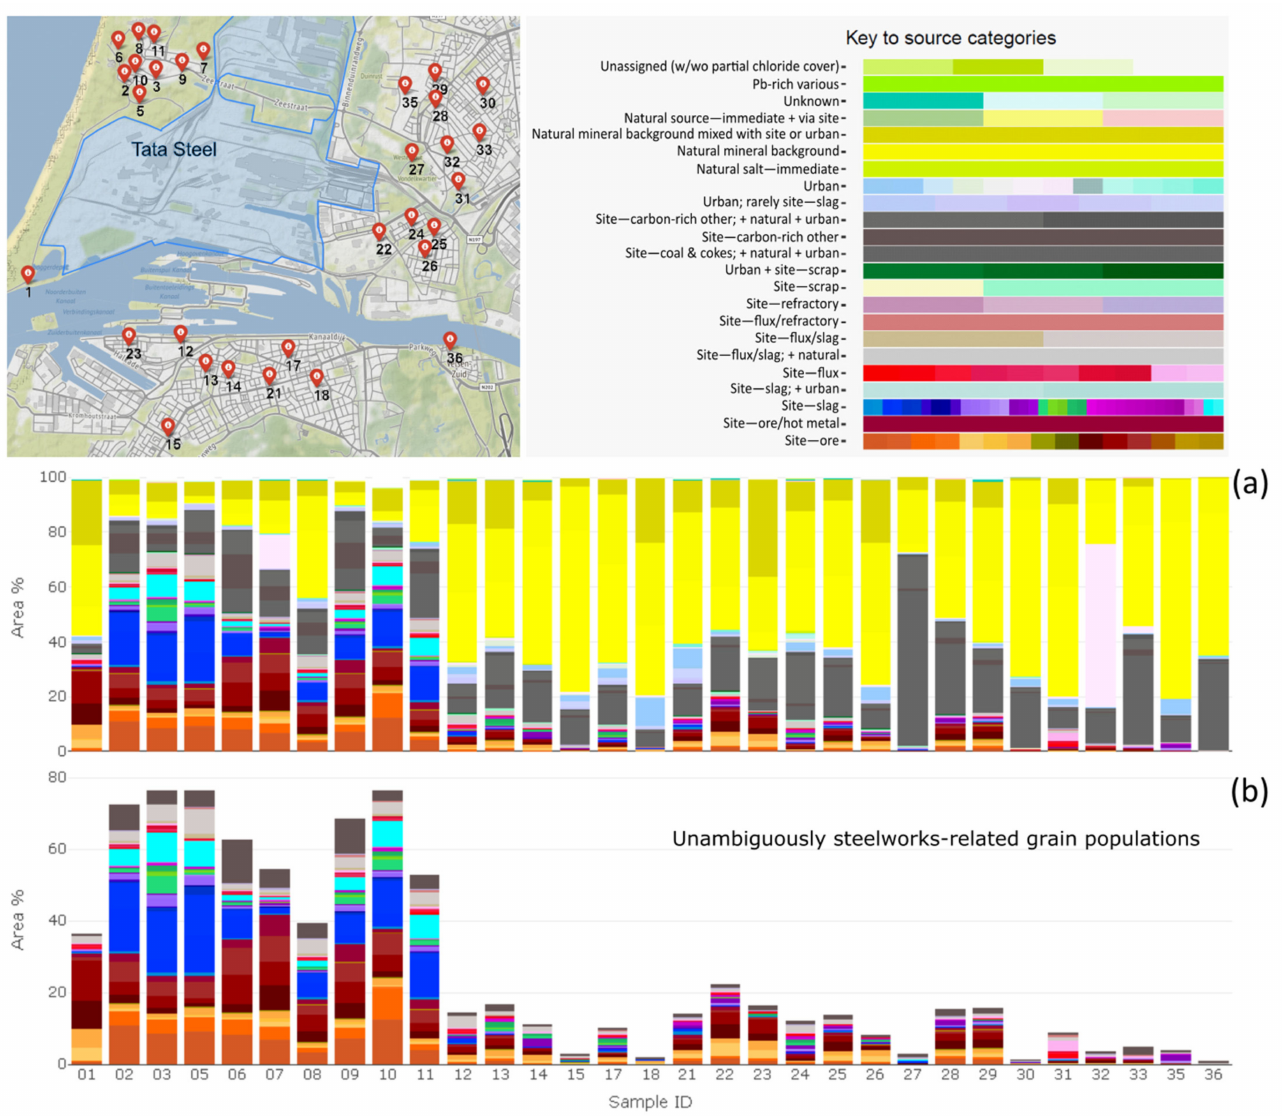
Figure 8. Overview stacked bar chart summarising abundances (silhouette area %) of all grain populations for all samples. Colour-scheme used for grain populations is shown in full in Supplementary File S3B. Population groupings into interpretive categories are shown in the key in the figure (explanations provided in Table 1). ( a ) shows all grain populations; ( b ) shows only unambiguously steelworks-related grain